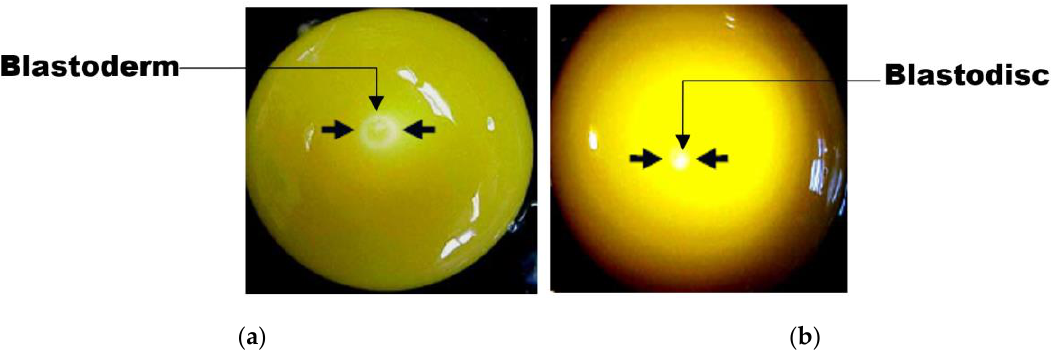
Figure 4. Chicken egg fertility identification: ( a ) blastoderm and ( b ) blastodisc.